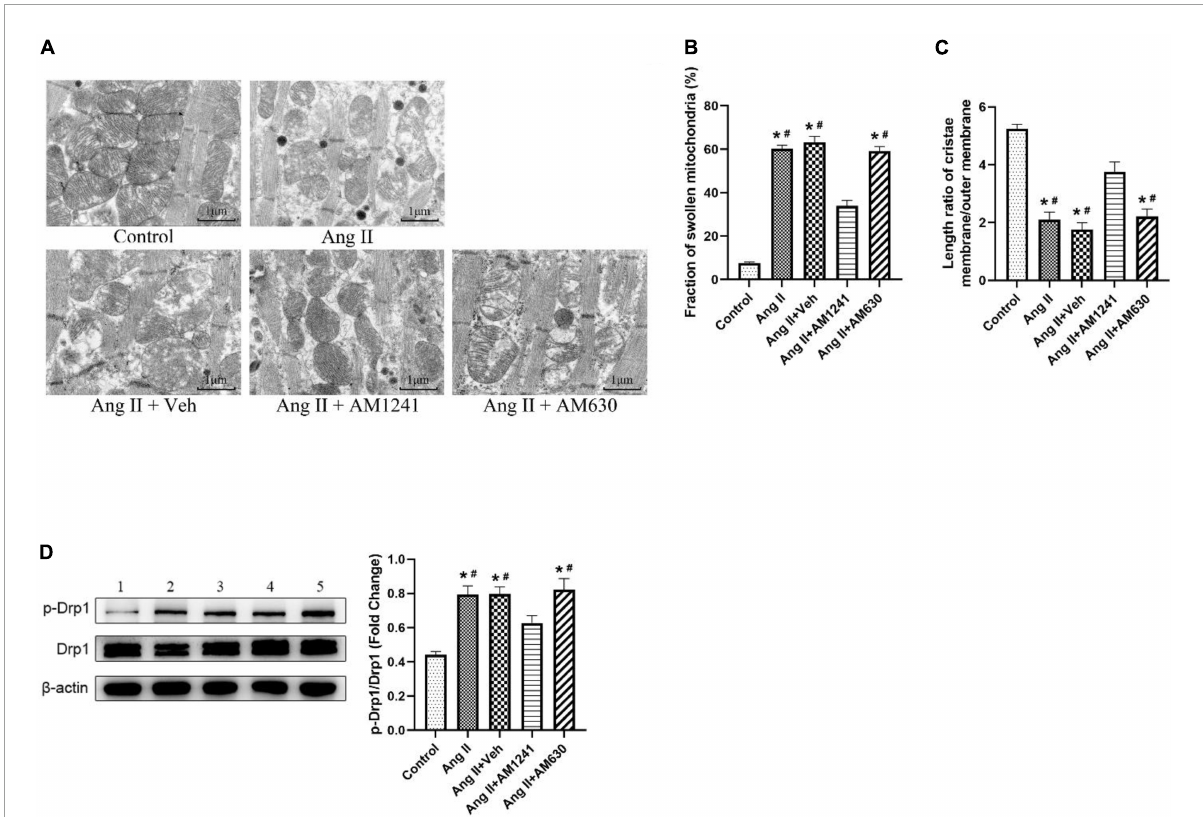
FIGURE4 Administration of AM1241 attenuated mitochondrial damage in Angiotensin II-infused mice. (A) Representative transmission electron microscopic images of atrial samples. Bar = 1 µ m. (B) Fraction of swollen mitochondria. (C) Length ratio of the mitochondrial cristae membrane and outer membrane, a parameter of mitochondrial cristae density. For each analyzed mitochondrion, the total length of the cristae membrane was obtained by adding the lengths of all the cristae together and multiplying by 2. The ratio was determined by dividing the total length of the cristae membrane by the mitochondrion perimeter. (D) Representative western blot image and relative expression of p-Drp1 and Drp1. Lane 1: control group; Lane 2: Ang II group; Lane 3: Ang II + Veh group; Lane 4: Ang II + AM1241 group; Lane 5: Ang II + AM630 group. The data represent the mean ± SEM. * P < 0.05 vs. control group. # P < 0.05 vs. Ang II + AM1241